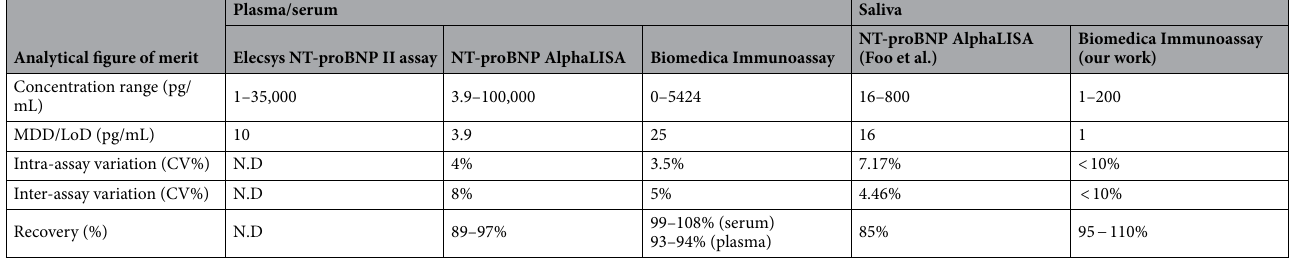
Table 2. Performance of assays used to determine NT-proBNP in plasma/serum and